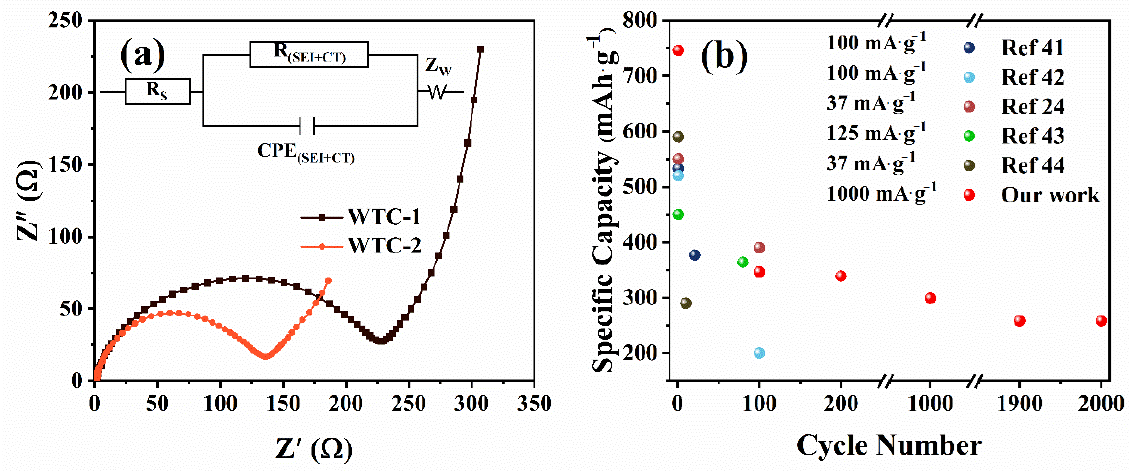
Figure 5. ( a ) Electrochemical impedance plots of WTC-1 and WTC-2; insert shows the equivalent circuit of the Nyquist plot of WTC−2 and ( b ) compares its electrochemical performance with previous reports of waste tire carbon.